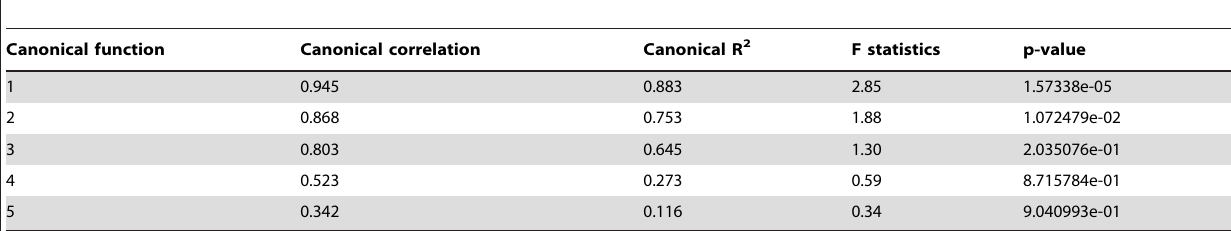
Table 3. Canonical Correlation analysis relating probe signals and fiber characteristics with the measure of overall model fit.